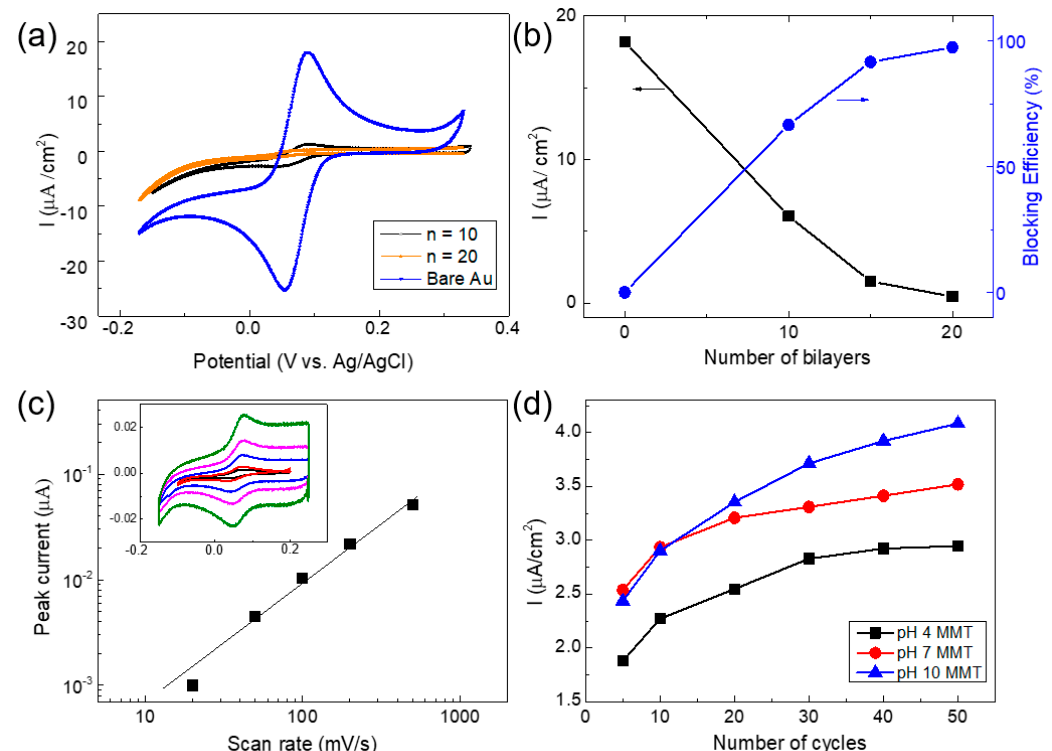
( a ) Cyclic voltammograms of (MMT-PEI) n -coated gold electrodes in IC solution. Scan rate = 10 mV / s. IC solution = 0.2 M HCl aqueous solution with 0.25 mM IC. ( b ) Anodic peak values (black) and blocking e ffi cacy (black) of (MMT-PEI) n -coated gold electrodes shown in Figure 3a. ( c ) Anodic peak current of (MMT-PEI) n assembled at pH 4 as a function of scan rate. Inset shows the CVs at di ff erent scan rates. ( d ) Peak currents of (MMT-PEI) n samples as a function of the number of CV